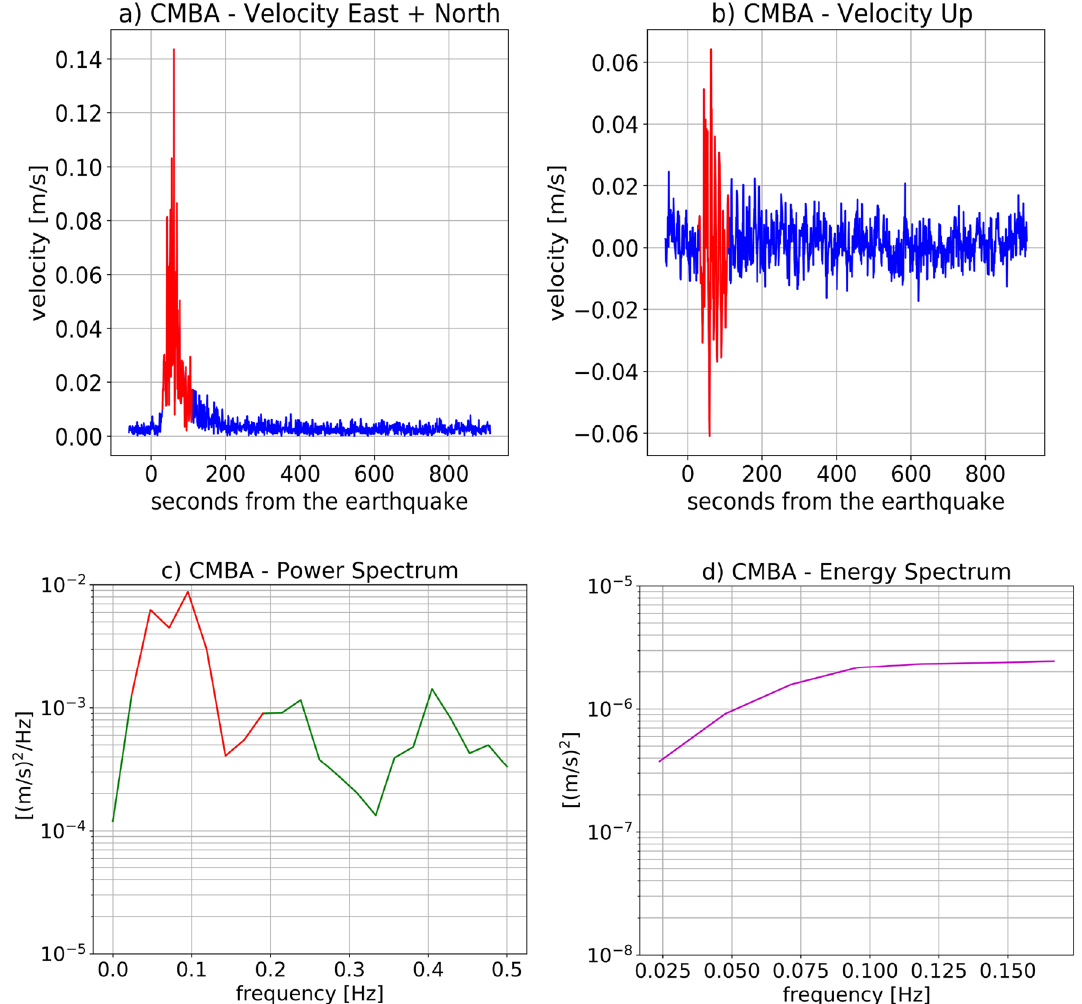
Figure 3. ( a , b ) Velocity time series for CMBA GPS station placed north of the epicenter. Specifically, ( a ) and ( b ) show the horizontal component and the Up component of the velocity respectively. The duration was computed on the horizontal component and then applied to the Up component of velocity. The red part highlights the earthquake duration detected with the Levene test. ( c ) The PSD for CMBA station. In red the chosen frequency range (3.3–200 mHz) for the integration. ( d ) The kinetic energy spectrum due to shaking in vertical direction for CMBA ◦ The elevation cut-off angle of 20 was used in order to remove the noisier observations as usually suggested in the literature 2 . The bottom panels of Fig. 2 (the right panel is a zoom in of the green rectangle of the left one) give a general vision of sTEC time series variations for all satellites and all stations, referred to the respective IPP positions 8 min after the earthquake, and sorted by the IPP corresponding distances (positive and nega- tive distances represent respectively the IPP placed north and south of the epicenter from the epicenter at this epoch). It is important to highlight that overall 11 GPS satellites (G02, G05, G06, G12, G13, G14, G15, G20, G24, G25, G29) observed from the 118 GPS permanent stations showing the much higher spatial coverage of the ionospheric observations (bottom panels of Fig. 2) compared to the GNSS ground motion observation only (upper panel of Fig. 2). The right panel of Fig. 4 shows the area analysed in which the coloured tracks represent the sTEC variations at the SIPs (same positions of the corresponding IPPs projected on the Earth ellipsoid) from the earthquake time (22:54:49 GPS time) to 23:59:59 GPS time. The TEC perturbation computed in real-time by VARION and showed in the right panel of Fig. 4 is characterized by a favorable coverage and is consistent with the source extent, proving the potential advantages to use real-time sTEC observations for tsunami genesis estimation. Additionally, sTEC observations appear to correlate well with the vertical ground motion and the related kinetic energy showing a strong perturbation mainly located at the North of the epicenter. Video S1 in Supplementary Material shows the TEC perturbation appearing about 9.5 min after the earthquake and moving northward. The remarkable spatial density of ionospheric TEC observation by GNSS compared to ground motion (shown in Figs. 2 and 4) is simply related to fact that ground information is calculated only at the GNSS station location, instead the TEC measurements are located at the IPP between the GNSS station and the satellites. Consequently,